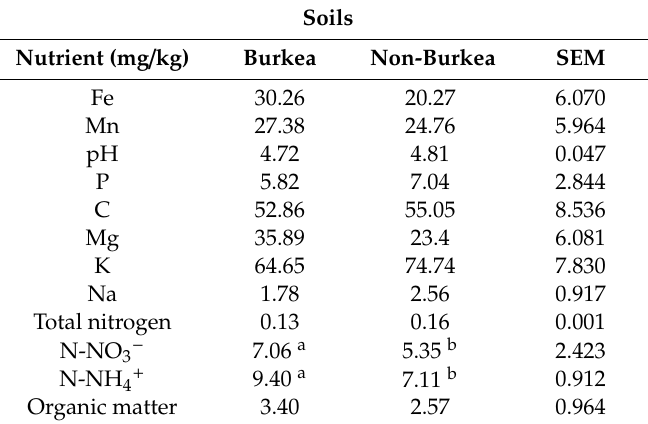
Table 1. Nutrient composition of Burkea versus non-Burkea soils.